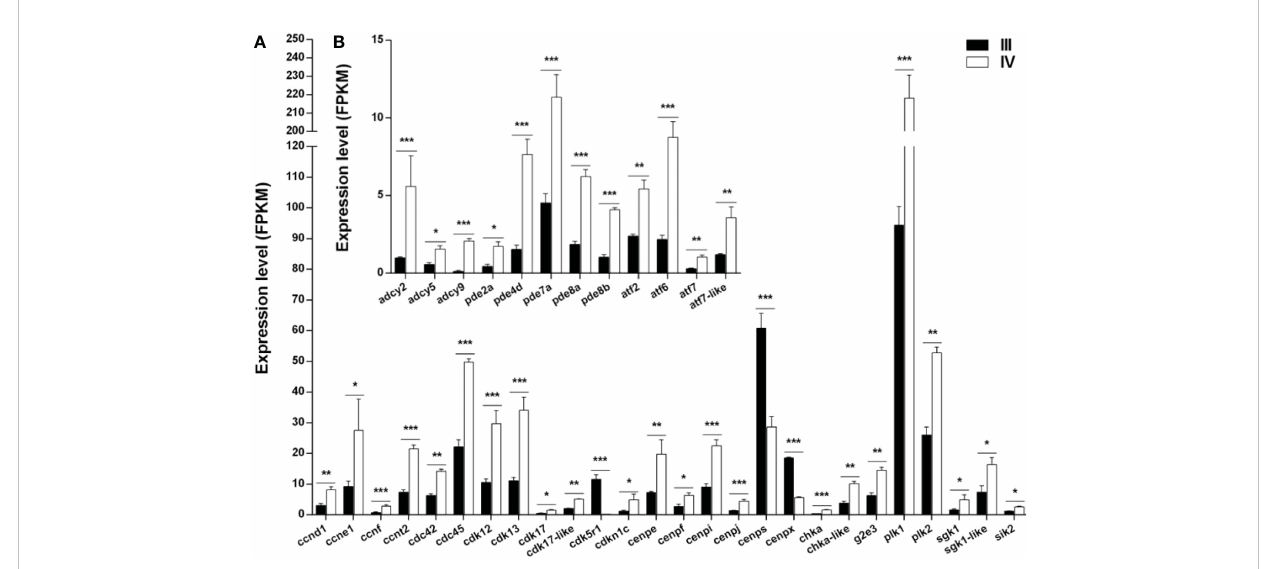
FIGURE 9 Histogram showing the selected differentially expressed genes (log2 (FC) >1 and FDR <0.05) involved in meiotic regulation in stage III and IV ovaries of S. argus . (A) Expression of genes associated with cell cycle and meiosis. (B) Expression of genes associated with cAMP or cGMP synthesis and hydrolysis. The data is based on the FPKM values obtained from the RNA-seq data. *, P<0.05; **, P<0.01; ***,